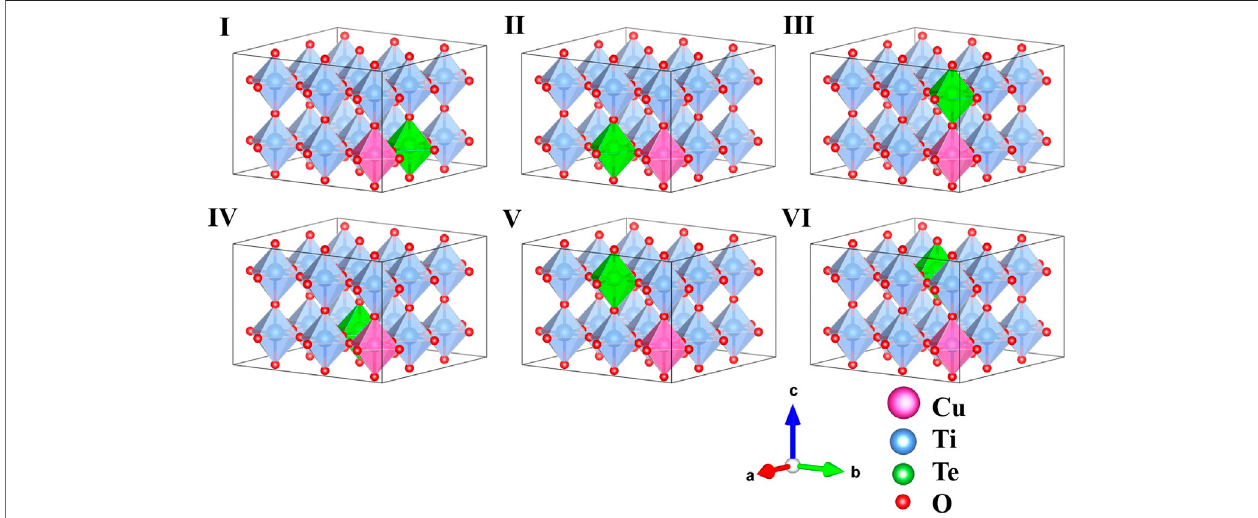
FIGURE1| Schematicrepresentationofthesixpossiblesymmetrydistinctcon fi gurationsof3 × 3 × 2perovskitesupercellofCu-Teco-dopedBaTiO 3 .Barium(Ba) atoms are not shown for clarity.